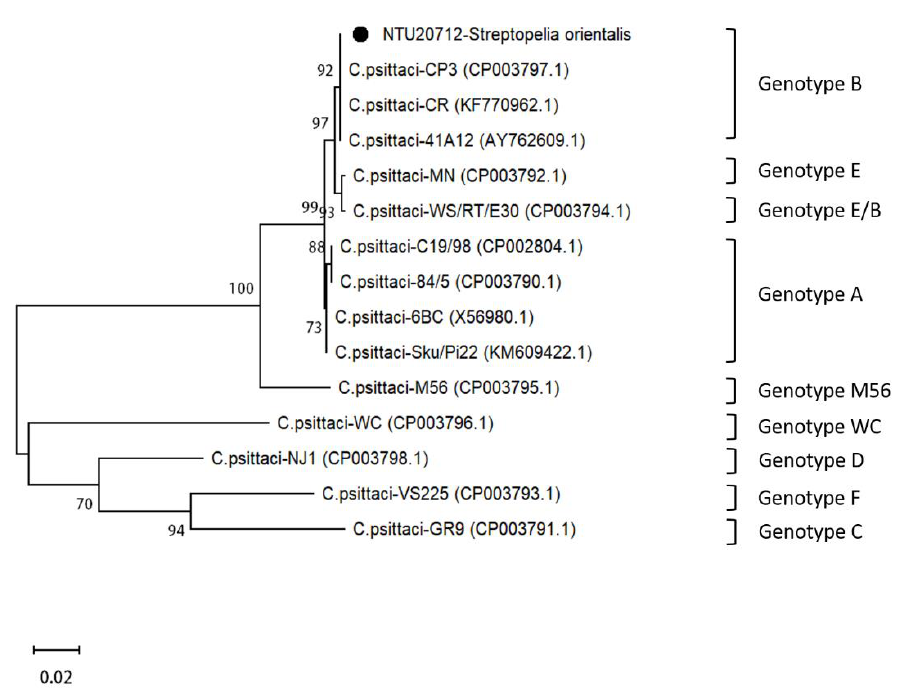
Figure 4. Phylogenetic analysis of Chlamydia psittaci based on sequences of the ompA gene. The black dot indicates the C. psittaci strain detected in the present outbreak. The GenBank accession numbers are shown in